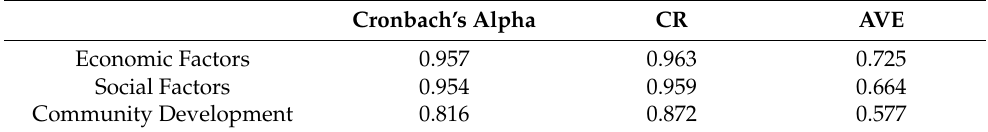
Table 3. Construct reliability and validity.